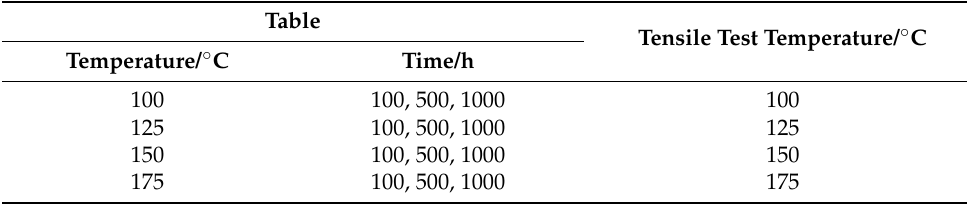
Table 1. Thermal exposure and tensile test conditions of 7085-T7452 Al alloy plate.